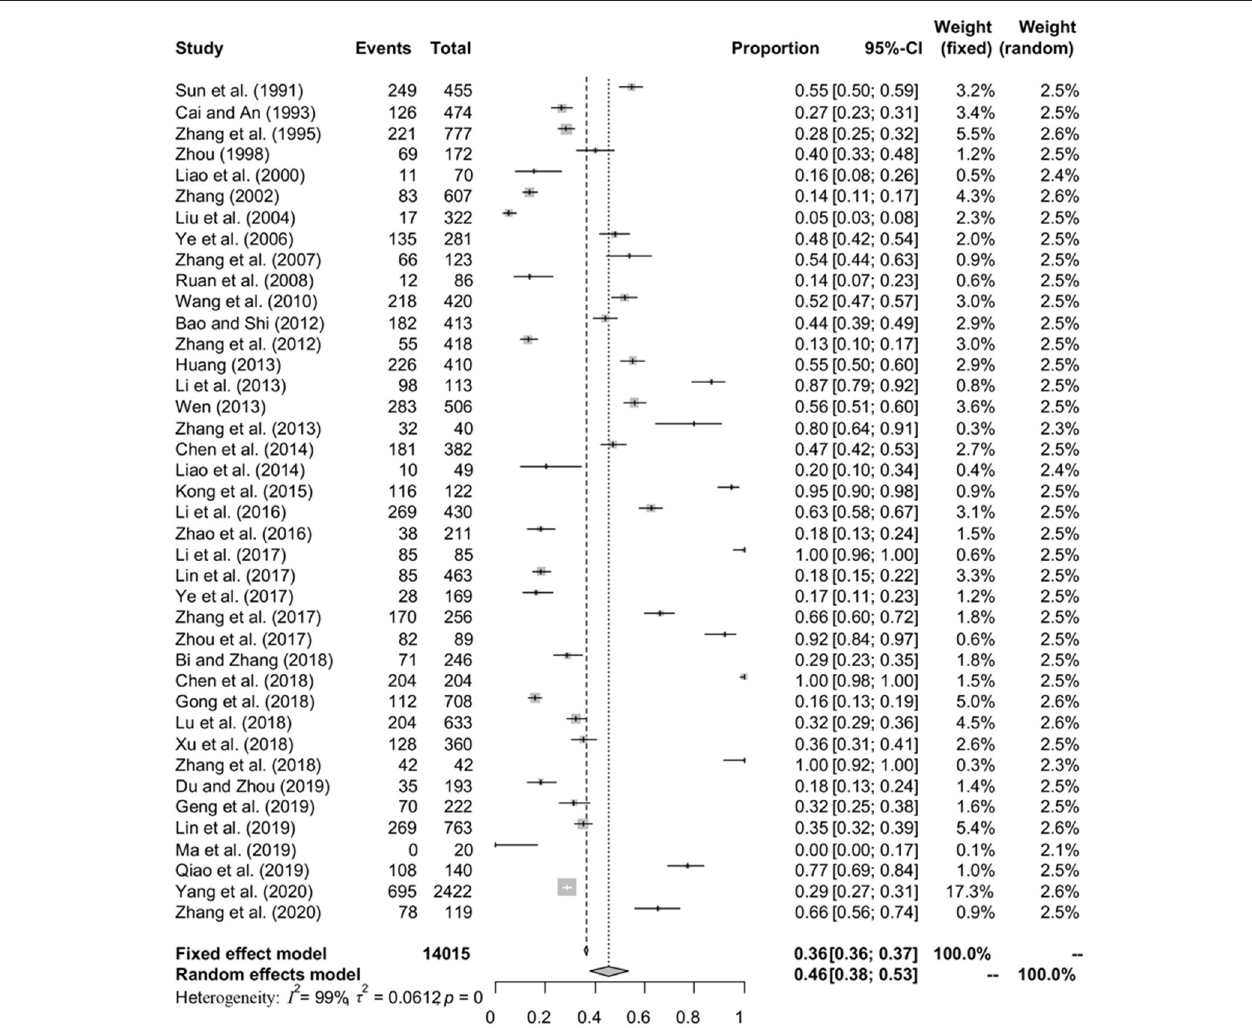
FIGURE 2 | Forest plot of prevalence of anisakids in fish amongst studies conducted in China. The length of the horizontal line represents the 95% confidence interval, and the diamond represents the summarized effect.